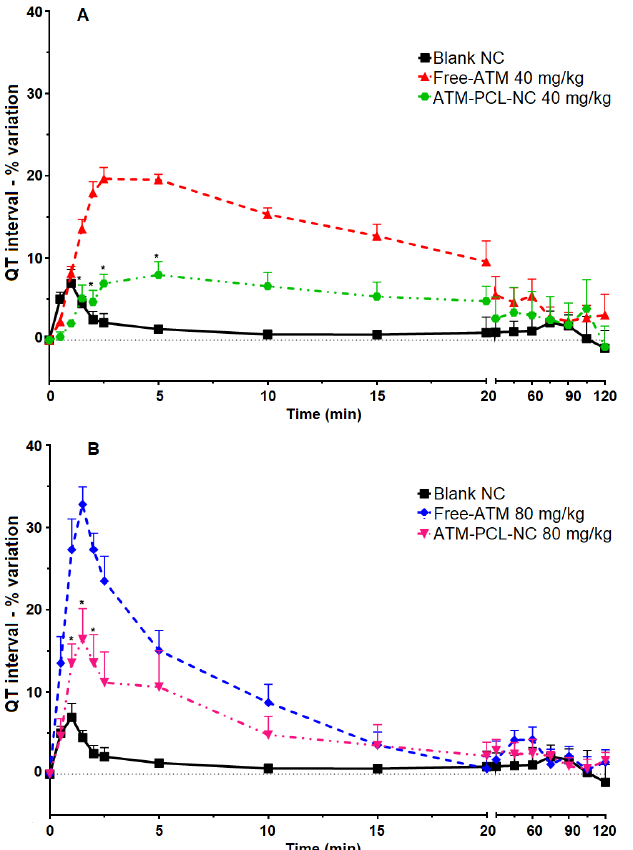
Figure 6. QT interval percentual variation from basal (before treatment) until two hours after IV single dose administration of blank-NC, free-ATM, and ATM-PCL-NC, both at 40 ( A ) and 80 mg/kg ( B ). * p > 0.05 compared to free-ATM administration. ANOVA followed by Tukey post-test. Figure 7 shows the maximum changes in cardiovascular parameters measured before and after ATM administration of a single dose of 40 mg/kg (A) or 80 mg/kg (B), and of the four doses (20 mg/kg) in 48 h (C). After the single IV dose, the QT interval increased by 19.6% and 32.8%, respectively for 40 mg/kg and 80 mg/kg of free ATM. Encapsulation of ATM in NCs significantly prevented ATM-induced QT interval prolongation ( p < 0.05), with approximately 60% and 50% of reduction after IV administration of 40 mg/kg or 80 mg/kg, respectively. Similarly, for the group receiving four repeated doses of 20 mg/kg free-ATM, the QT interval increased from 66.5 ms (basal) to 81.6 ms (two hours after the last dose of ATM-PCL-NCs). After the single dose, free-ATM reduced the blood pressure (SAP and DAP) (Figures 8 and 9A,B), and HR (Figure 7A,B), mainly from one to 20 min post-administration (Figures 8 and 9). The hypotension was severe with free-ATM (Figure